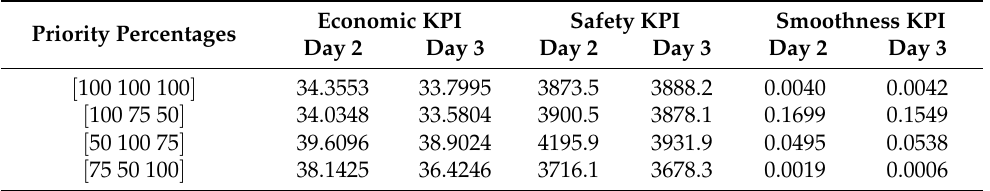
Table 2. KPIs for the DM Strategy using the ENNCP Method.